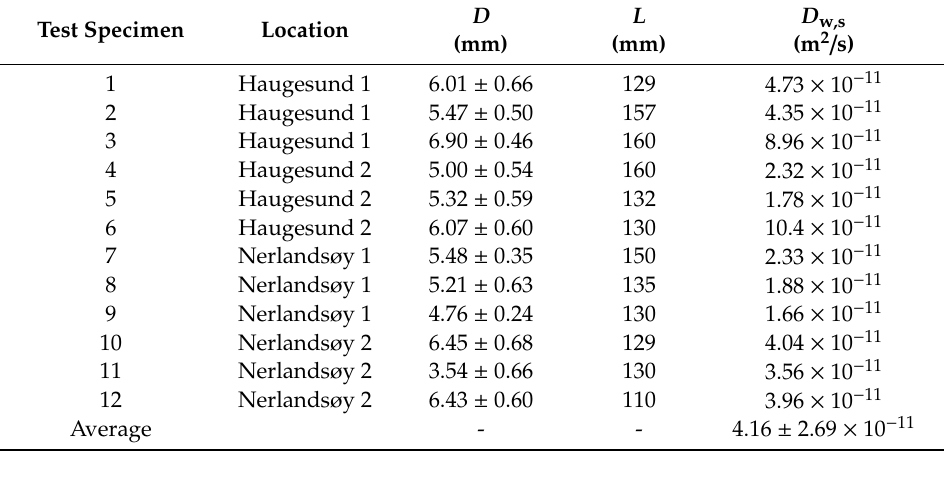
Table 1. Growth place, diameter, length and resulting moisture diffusion coefficient of the degenerated Calluna test specimens.